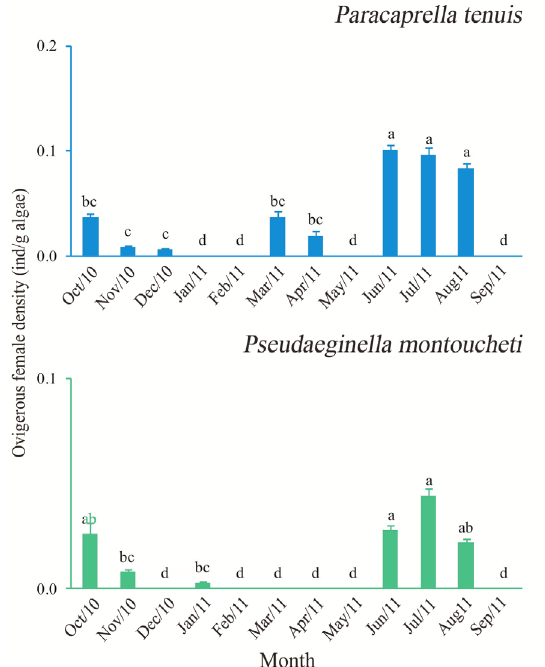
Figure 6. Monthly values of ovigerous female density (ind./g of algae) (mean ± standard error) of Paracaprella tenuis and Pseudaeginella montoucheti from October 2010 to September